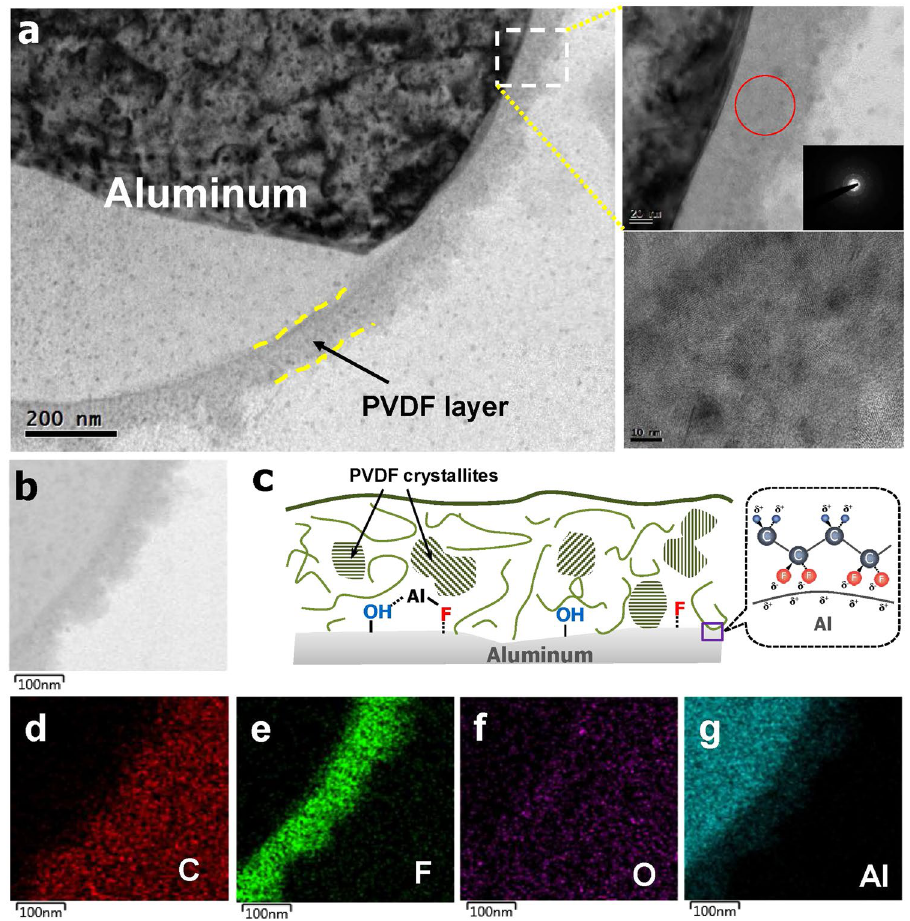
Figure 2. ( a ) Cross-sectional TEM image of a PVDF/Al particle; ( b ) enlarged TEM image of the PVDF-coated region; ( c ) schematic illustration showing the PVDF layer and surface-fluorinated PVDF/Al interface; and EDS results showing the distributions of ( d ) carbon, ( e ) fluorine, ( f ) oxygen, and ( g ) aluminum